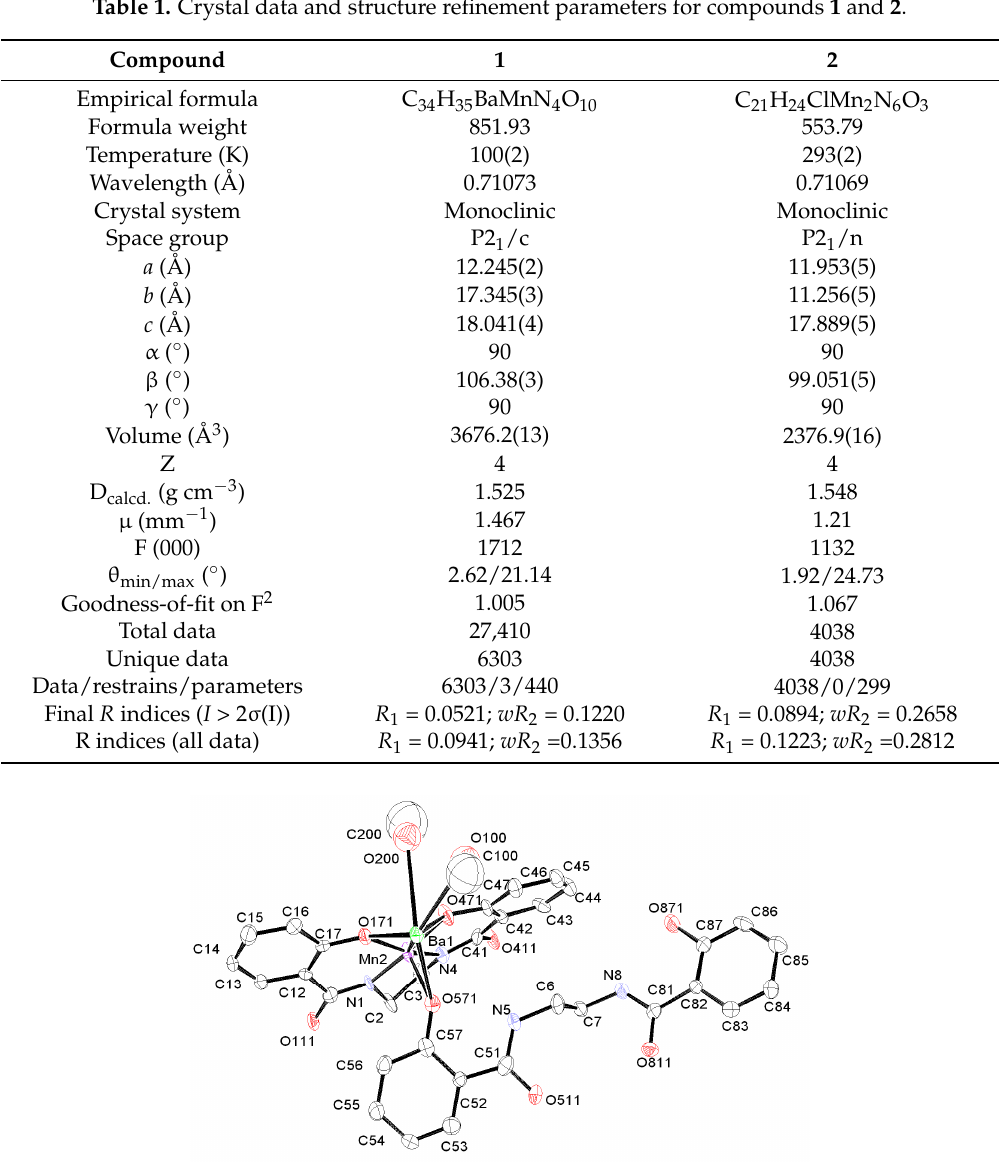
Figure 2. ORTEP view for the BaMnL 1 (H 3 L 1 )(CH 3 OH) 2 asymmetric unit for compound 1 , with atoms showing the atomic numbering scheme.